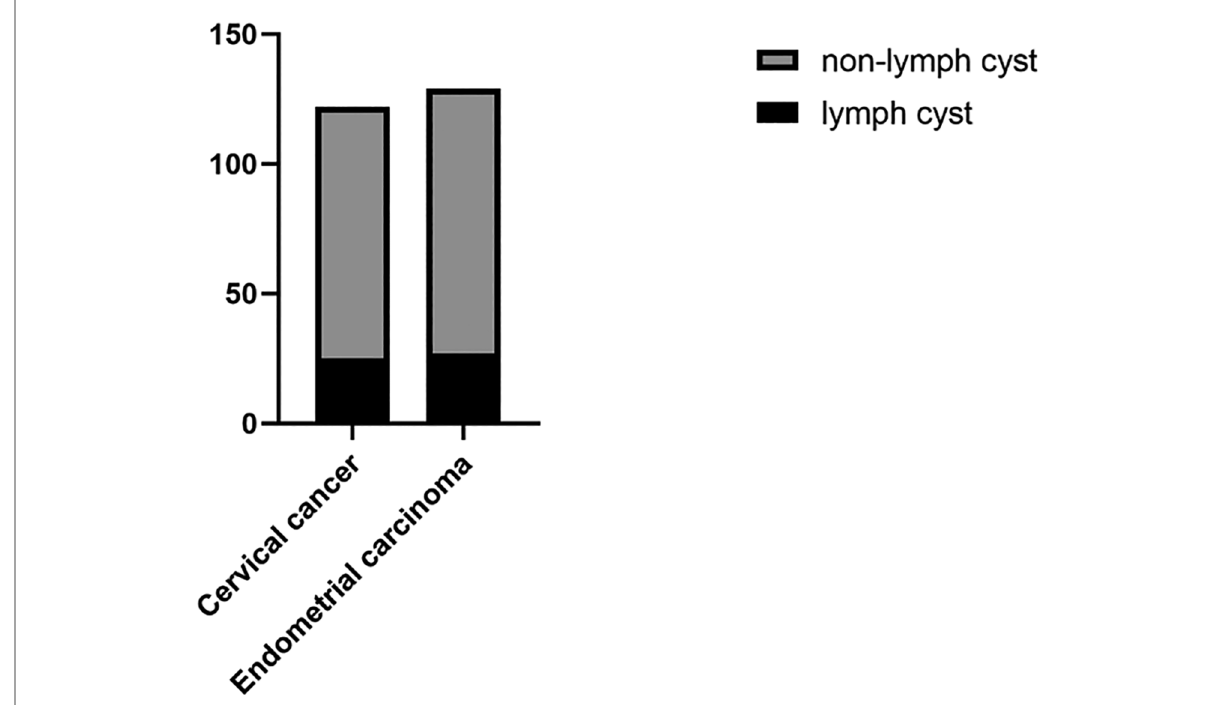
FIGURE 1 Incidence of lymph cyst.